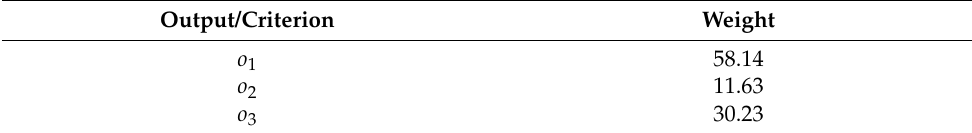
Table 8. Output weights for z = 5.